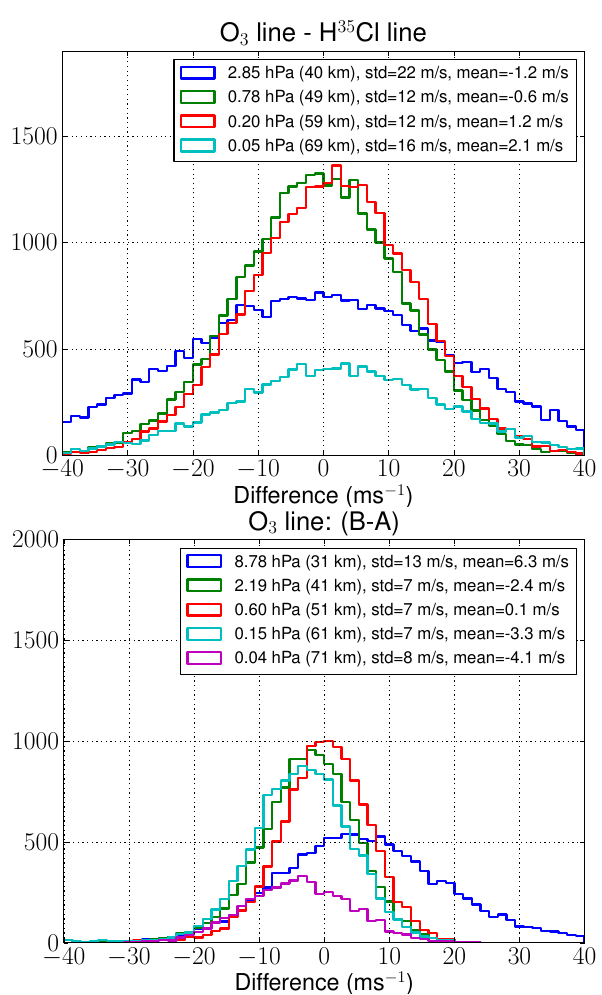
Fig. 7. Upper panel: histogram of differences of the velocity re- trieved from the O 3 and the HCl lines in band B. Lower panel: same as for the left panel but for line-of-sight winds retrieved from the O 3 lines in bands A and B measured simultaneously. Data for latitudes between 20 ◦ N and 60 ◦ N have been